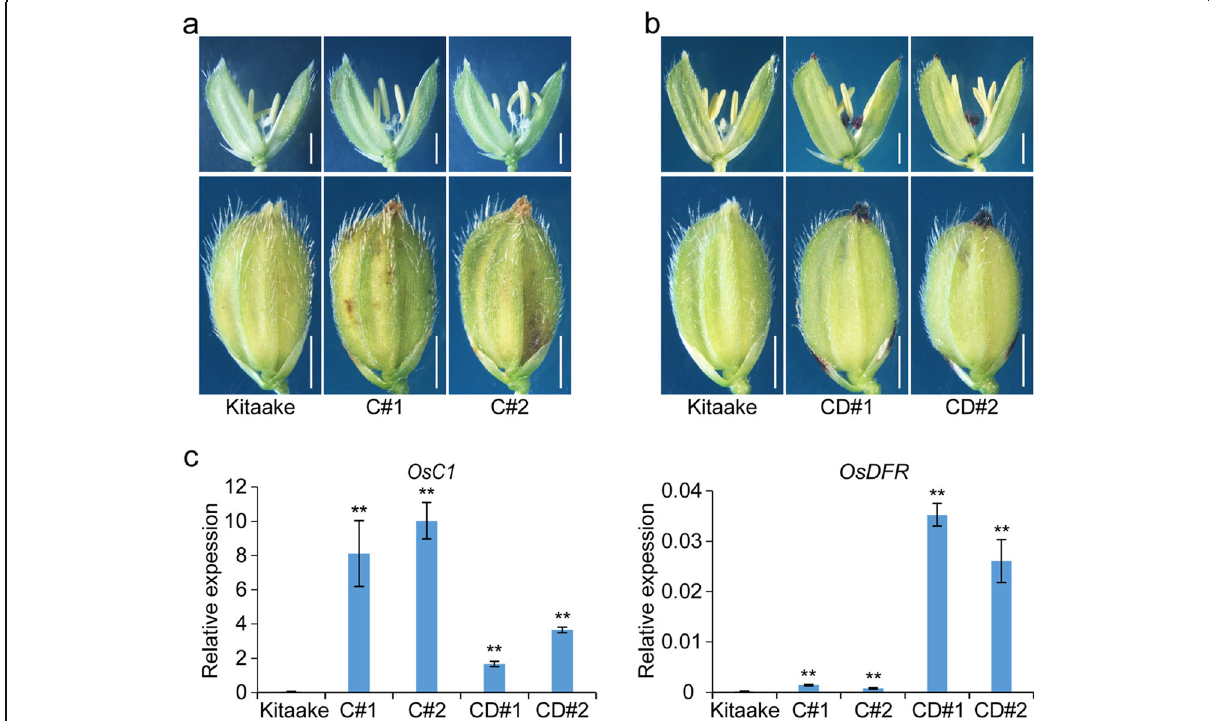
Fig. 2 Functional validation and expression analysis of OsC1 and OsDFR. a The straw-white apiculi became brown whereas stigmas remained straw-white after OsC1 was introduced into Kitaake. The top, spikelets 1 day post heading; the bottom, spikelets 14 days post heading. Bars, 2 mm. b Both apiculus and stigma became purple when both OsC1 and OsDFR were transformed into Kitaake. The top, spikelets 1 day post heading; the bottom, spikelets 14 days post heading. Bars, 2 mm. c Expression levels of OsC1 and OsDFR in Kitaake and complementation plants. C#1, C#2, two independent OsC1 -complemented lines. CD#1, CD#2, two independent complemented lines with OsC1 and OsDFR . Data are means ± SD of three biological replicates (Student ’ s t -test: ** P <